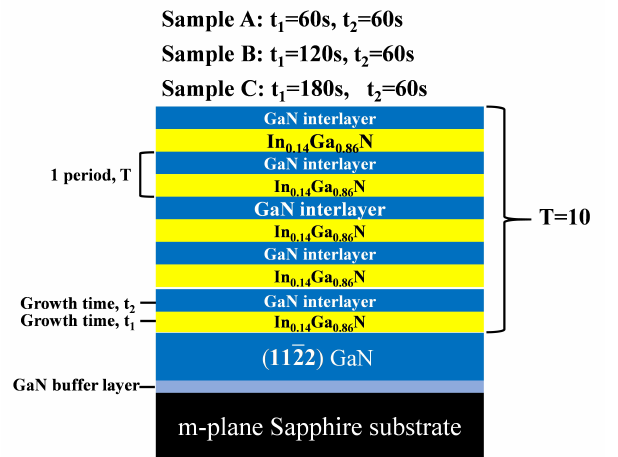
Figure 1. Schematic diagram of the In 0.14 Ga 0.86 N/GaN superlattice